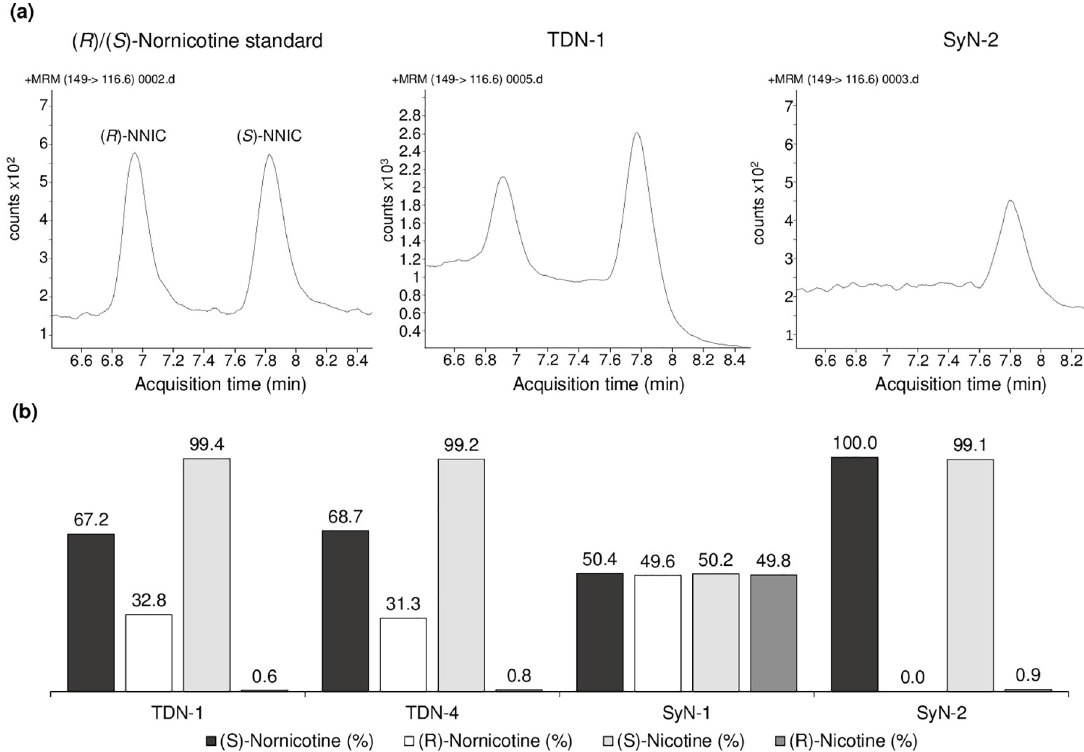
Fig 5. Chiral analysis of the ( R )- and ( S )-nornicotine analysis in tobacco-derived and synthetic nicotine samples. (a) Example chromatography in a racemic nornicotine standard, TDN-1, and SyN-2 (left-to-right), and (b) comparison of the ( R )/( S )-nornicotine ratio to the corresponding ( R )/( S )-nicotine